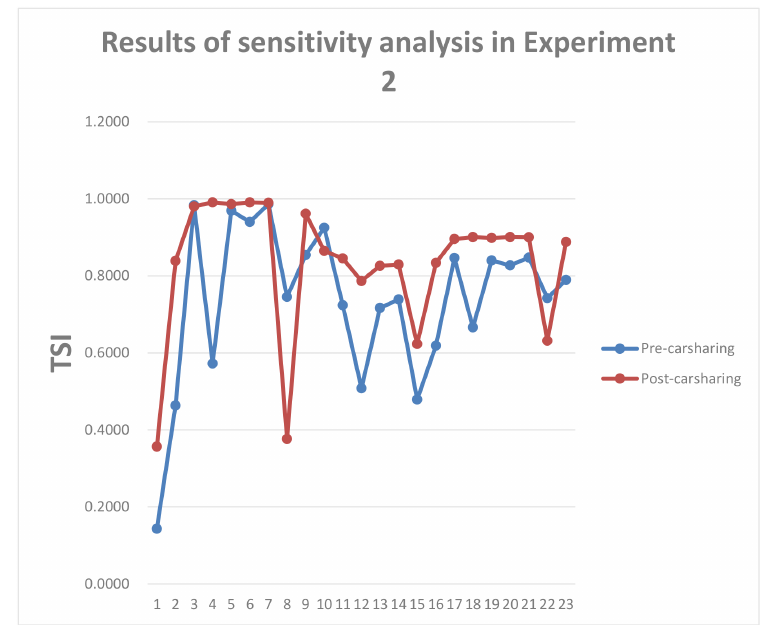
Figure 5. Results of sensitivity analysis in Experiment